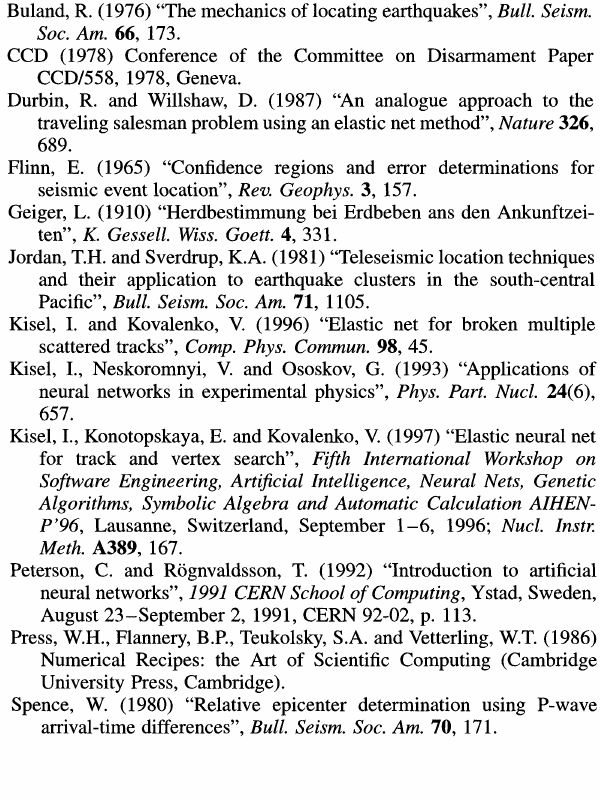
FIGURE 5 Efficiency of the epicenter searching depending on seismic data efficiency.